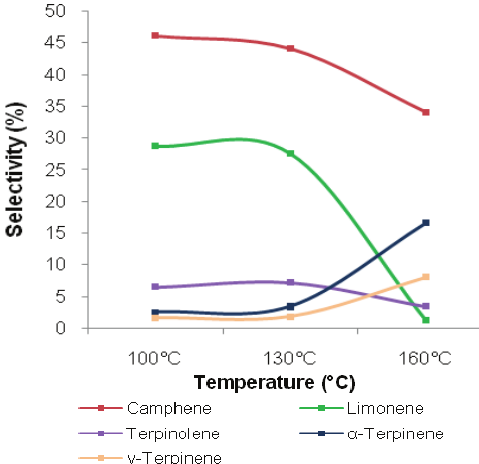
Figure 5. (a) Concentration of the major products in the reaction mixture depending on the reaction time for H ( α -pinene/catalyst ratio of 100/1, at 100°C); (b) Concentration of the minor products in the reaction mixture depending on the reaction